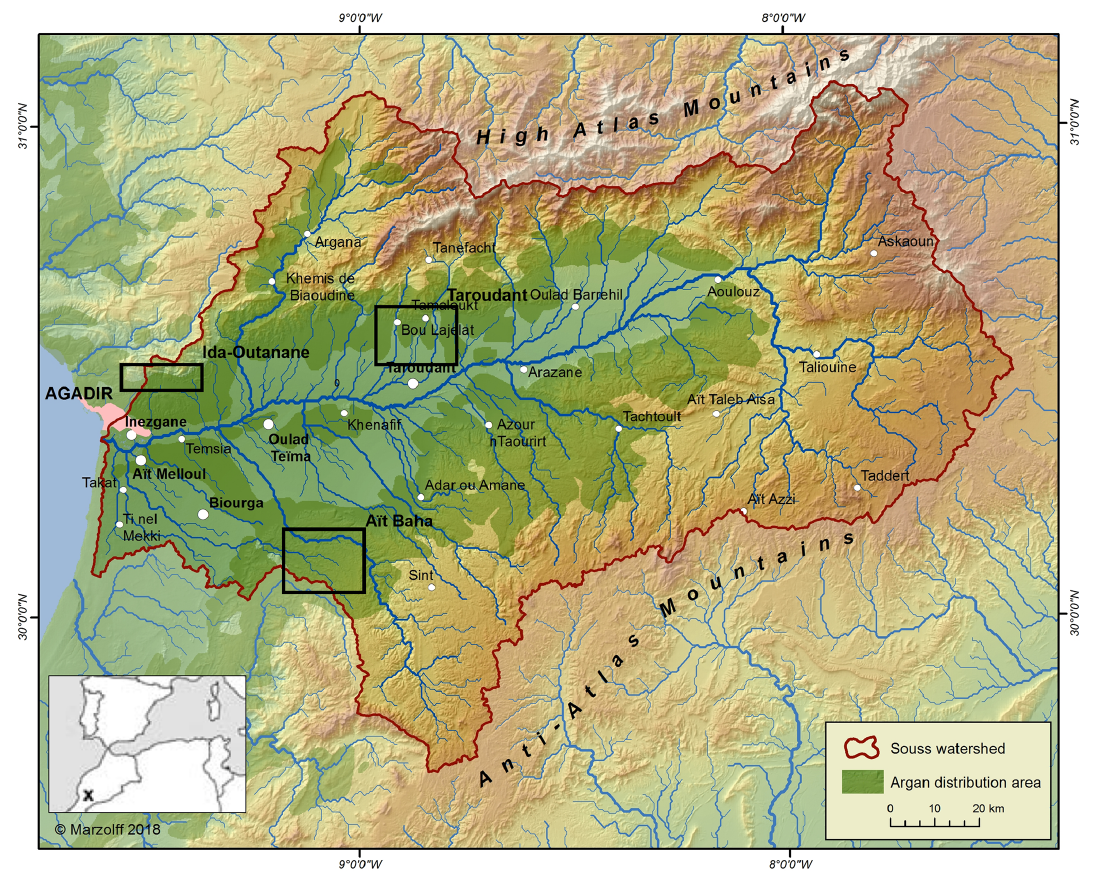
Figure 1. Study areas of Aït Baha, Ida-Outanane and Taroudant in the Souss basin (shown with black rectangles). The argan distribution area is shown in green shades (map modified from d’Oleire-Oltmanns et al., 2012).